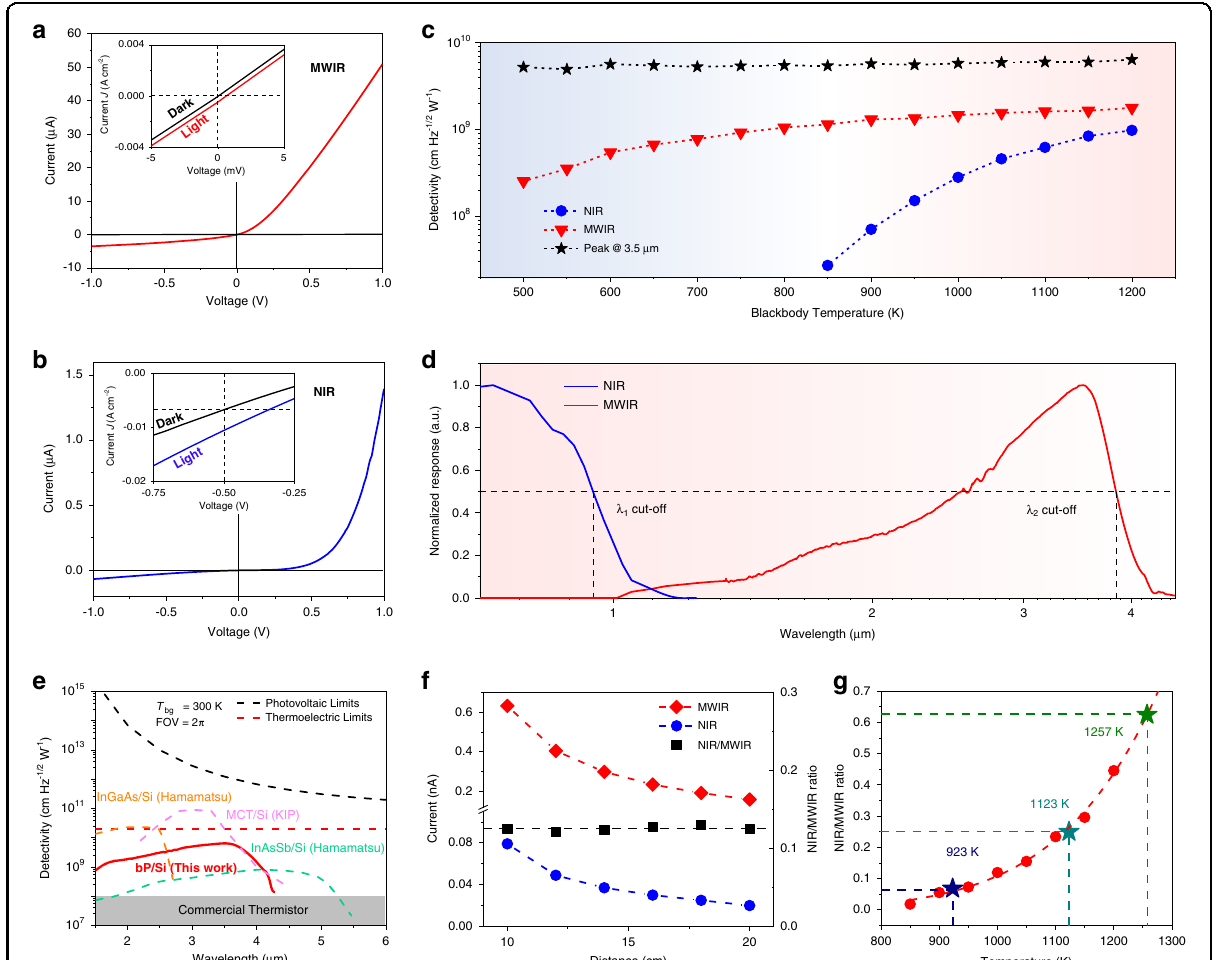
Fig. 2 Two-color performance characterization and colorimetric temperature measurement. a Dark current characteristics of bP/MoS 2 heterojunction photodiode in 300 K without illumination. Inset: the J-V characteristics of the device with or without a 1200 K blackbody source. b Dark current characteristics of Si/MoS 2 heterojunction photodiode in 300 K without illumination. Inset: the J-V characteristics of the device with or without a 1200 K blackbody source. c Speci fi c detectivity at different blackbody temperatures. d Normalized spectral response of the two-color photodetector during the back radiation. The 0.7 – 1.3 μ m of the spectrum was measured by a grating spectrometer. The 1.3 – 4.5 μ m of the spectrum was measured by FTIR. All FTIR and laser diode characterization were performed at a bias of 0 V (MWIR) and − 0.5 V (NIR). e Speci fi c detectivity as a function of wavelength measured for a bP/MoS 2 /Si heterojunction at room temperature as well as various commercially available and reported NIR/ MWIR two-color photodetectors, including MCT/Si (Kunming Institute of Physics), InGaAs/Si (Hamamatsu K1713-08) and InAsSb/Si (Hamamatsu K1713-003). All FTIR and laser diode characterization was performed at a bias of 0 V. The black line in the fi gure is the performance limit of photovoltaic devices; the red line is the performance limit of thermoelectric device; the gray box is commercial thermistor. f Left axis, NIR and MWIR signals as a function of photodetector – blackbody distance. Right axis, the relationship between the NIR/MWIR ratio and photodetector – blackbody distance. g NIR/MWIR ratio depends on the blackbody temperature. Red dots show the measured NIR/MWIR ratio in each blackbody